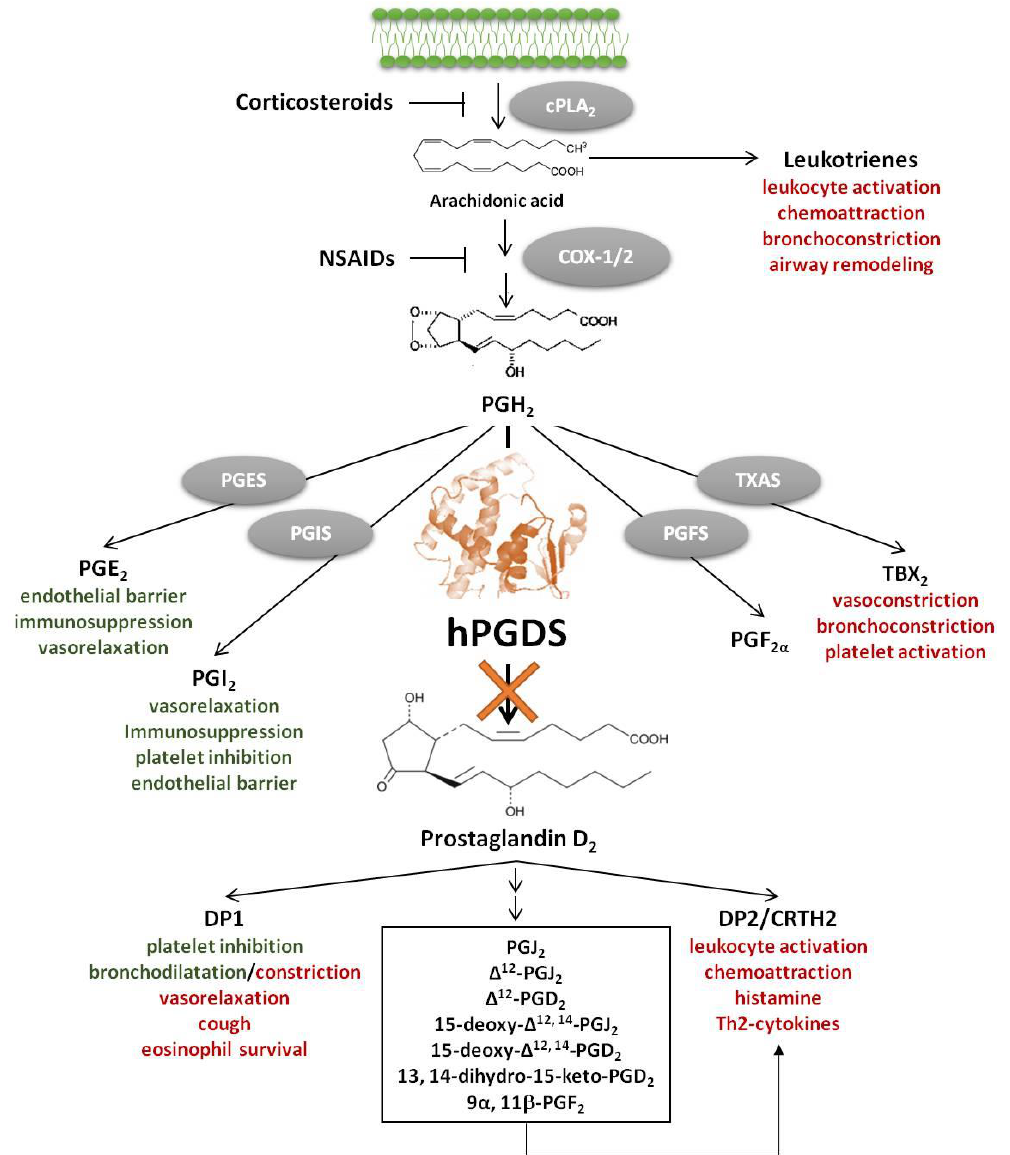
Figure 1. hPGDS as therapeutic target downstream of the arachidonic acid / cyclooxygenase (COX) pathway. Hematopoietic PGDS inhibition specifically targets PGD 2 and PGD 2 metabolite production—mediators that primarily activate pro-inflammatory DP2 / CRTH2 receptor [1]. Non-steroidal anti-inflammatory drugs (NSAIDs) block all lipid mediators downstream of COX-1 / 2, including potentially beneficial e ff ects of PGE 2 and PGI 2 . Corticosteroids are standard-of-care therapeutics of asthmatic patients that e ff ectively block all downstream products of arachidonic acid including leukotrienes; however, therapy interferes with many physiological processes causing numerous adverse e ff ects. Favorable e ff ects of selected lipid mediators in allergic inflammation highlighted in green; unfavorable e ff ects highlighted in